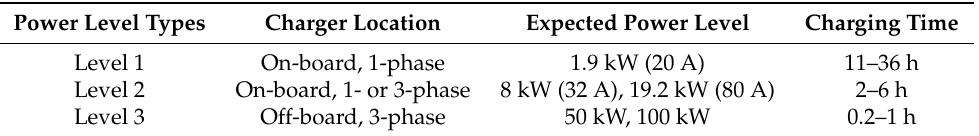
Table 2. Charging Power Levels